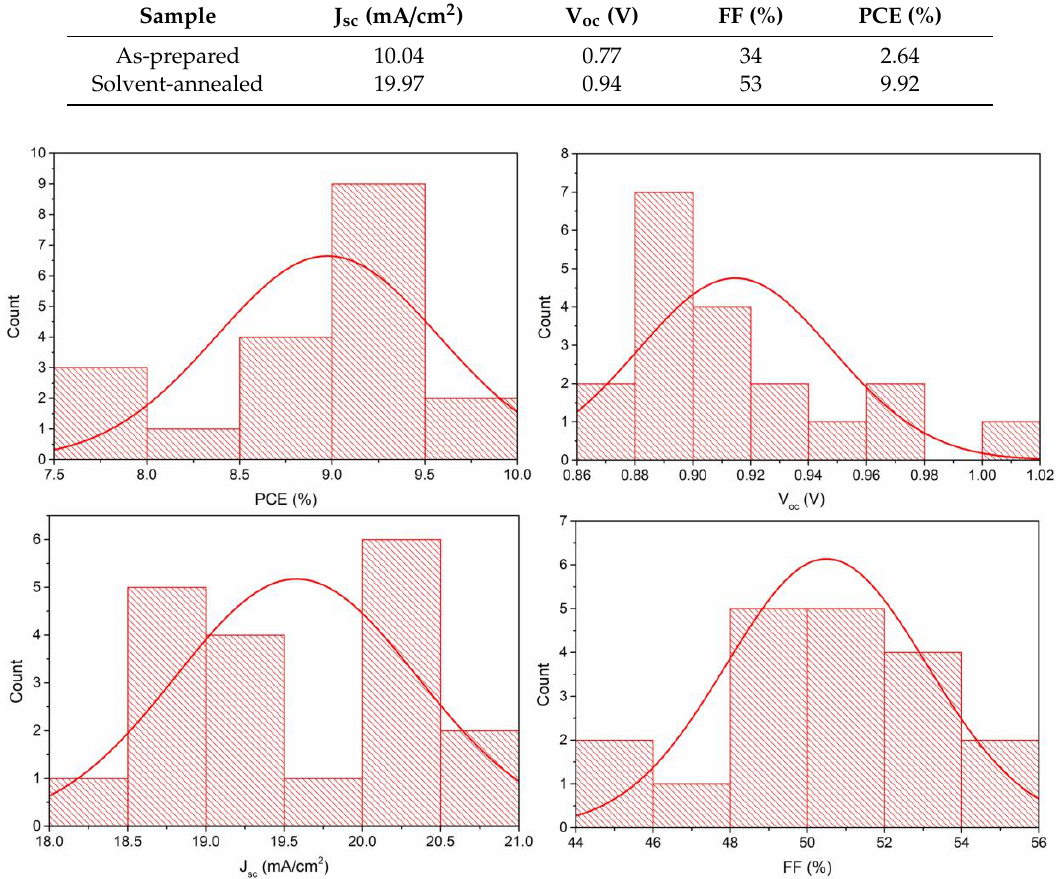
Figure 8. The histograms of the PCE, V oc , J sc , and FF distribution based on 19 perovskite solar cells.